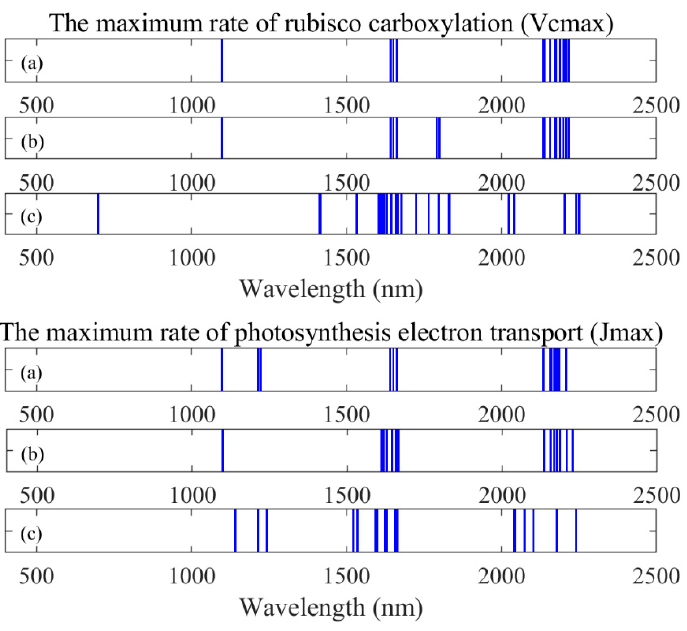
Figure 7. Useful wavelengths from all index types for photosynthetic capacity. (a) Original reflectance, (b) first-order derivatives spectra, and (c) apparent absorption.